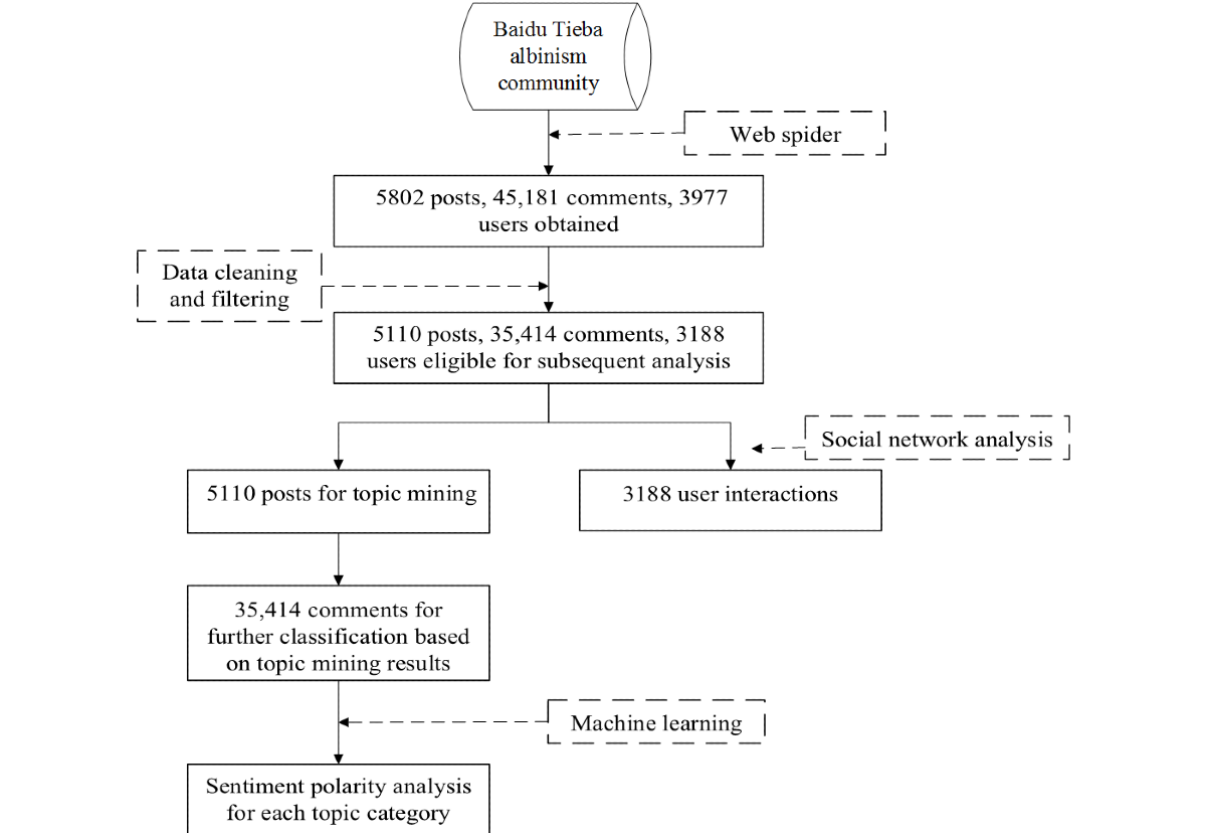
Figure 1. Flowchart for identifying data from the online albinism Baidu community for subsequent